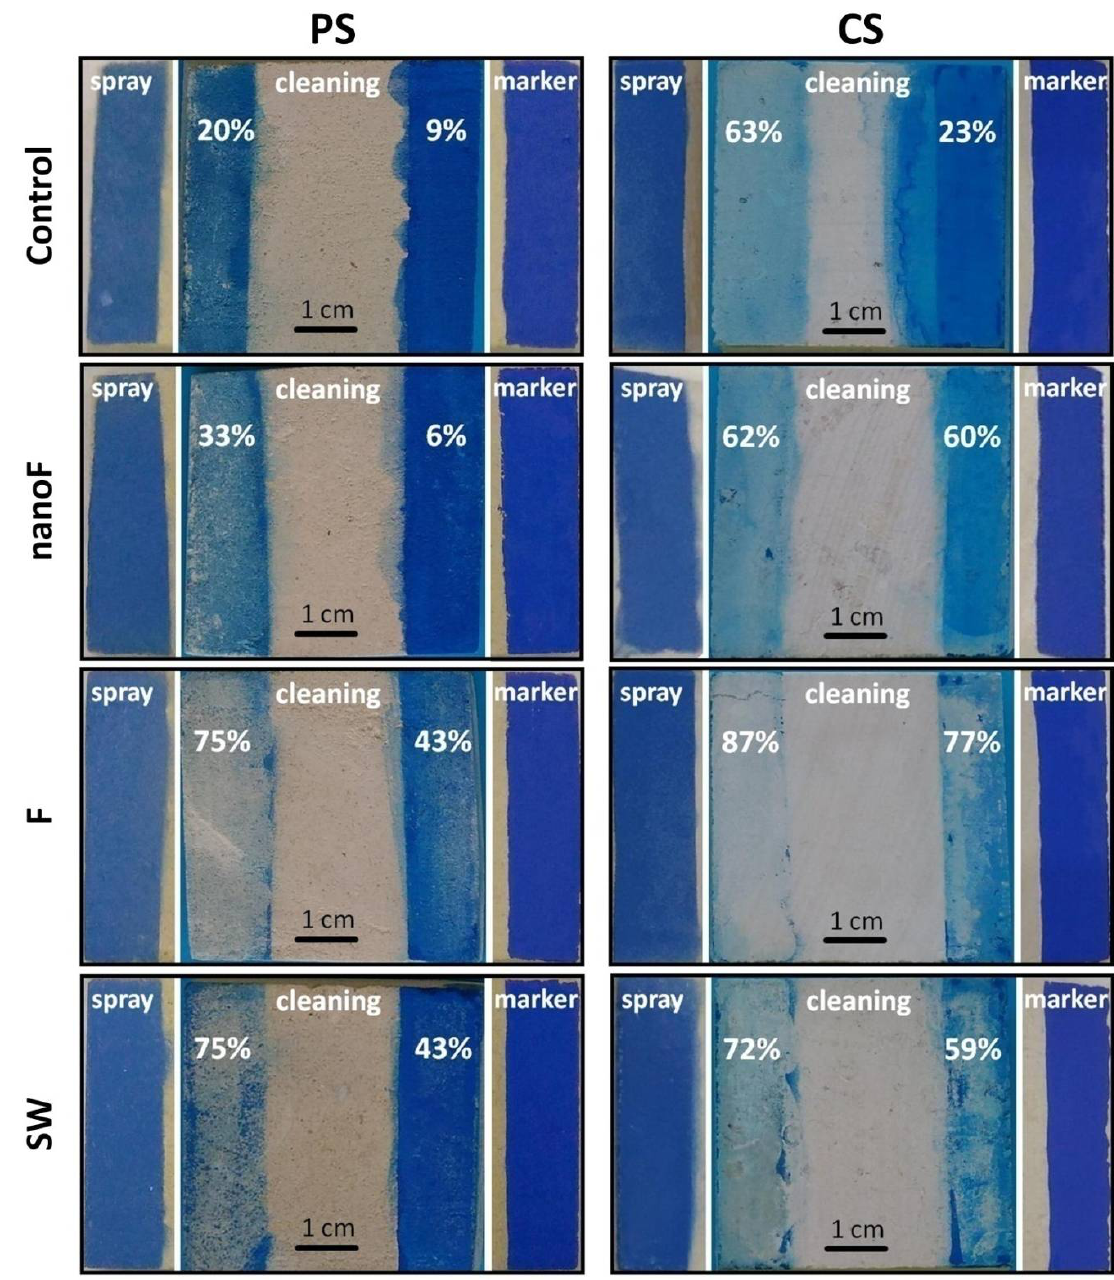
Figure 5. Stone samples after the staining and after the cleaning procedure; the CE values, as defined in Equation (5), are reported for the cleaned areas. The un-stained stone surface is in the middle of each image.